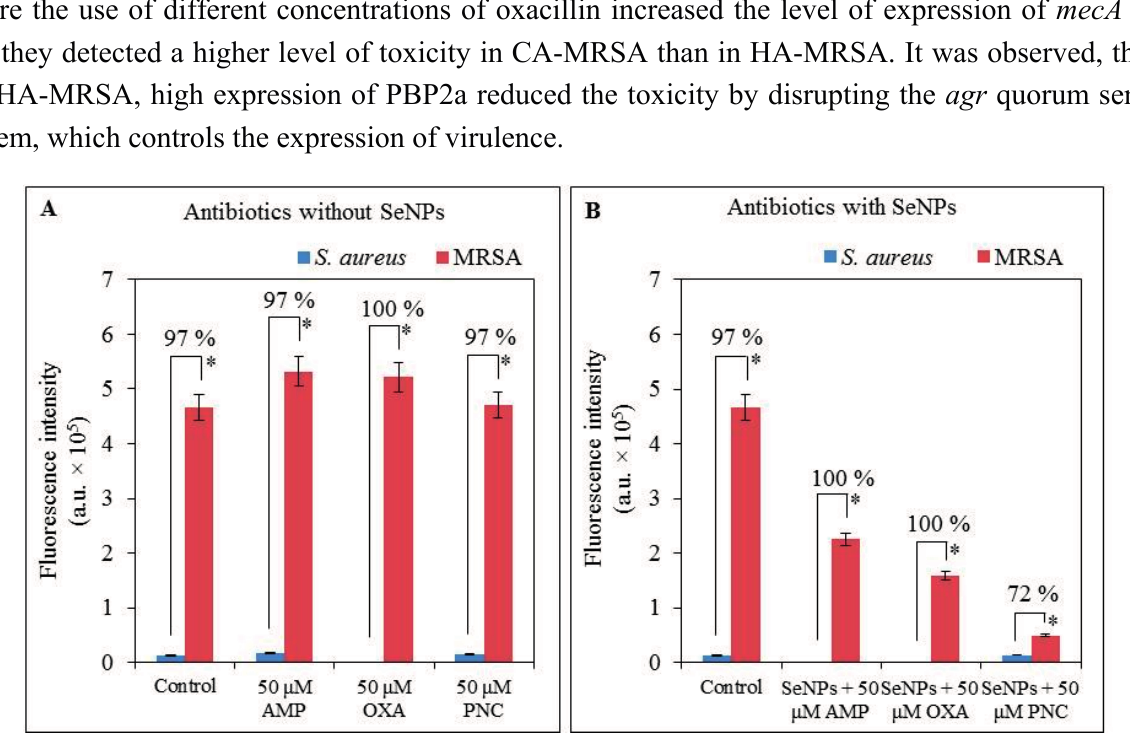
Figure 3. Monitoring of mecA gene expression in bacterial strains S. aureus and MRSA after 24 h of growth with ( A ) 50 µM ATBs concentration and with ( B ) 100 µM concentration of SeNPs with 50 µM ATBs concentration in complexes using PCR and subsequent gel electrophoresis. Controls are bacterial strains ( S. aureus and MRSA) without application of antibacterial component. All data represent mean ± S.D. NS, not significant, * p <